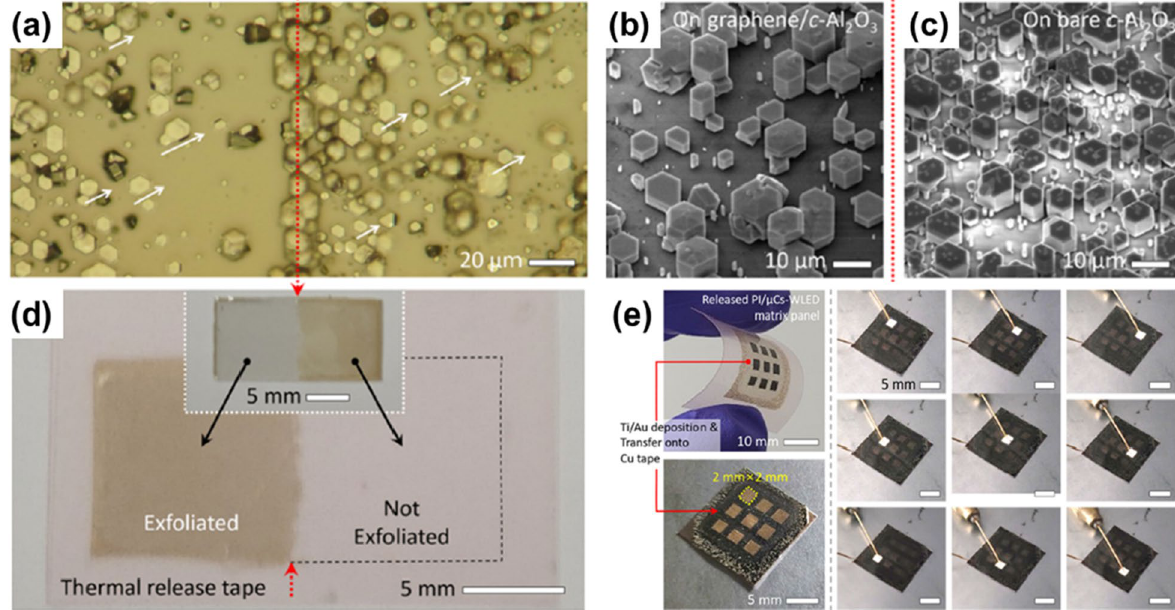
Fig. 5 Remote epitaxy of 2D materials on sapphire (Al 2 O 3 ) substrates and the principle. a Optical microscopic image of GaN microcrystals (μCs) taken at around the boundary between graphene/Al 2 O 3 and bare Al 2 O 3 surfaces. Based on the red dotted line, the left is on graphene/Al 2 O 3 and right is on bare Al 2 O 3 . Tilted‑view SEM images of GaN μCs grown on b graphene/Al 2 O 3 and c bare Al 2 O 3 . d Photograph of the thermal release tape after the delamination of polyimide‑encapsulated GaN μCs. The inset of d shows a photograph of the substrate after the exfoliation process. e Flexible white μCs‑LED matrix arrays fabricated by forming patterned electrodes. Figure reproduced from ref. [190],